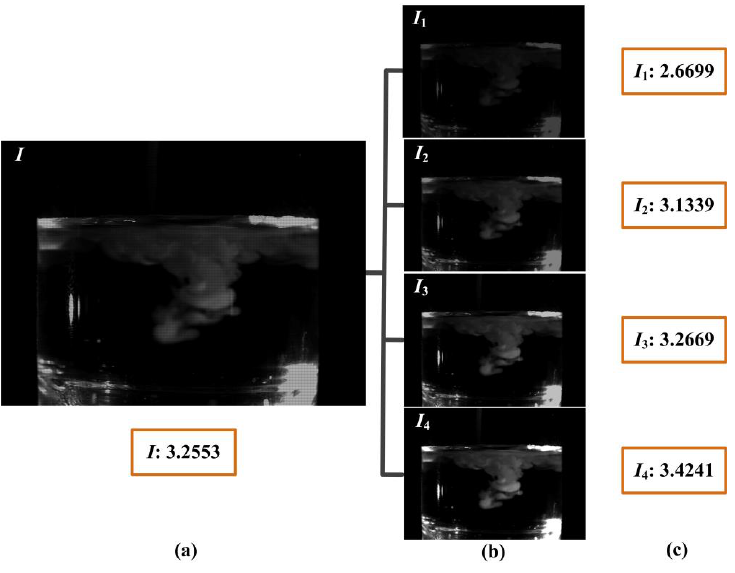
Figure 11. The third example result of coded exposure for subtle change of the liquid mixing motion. ( a ) Coded exposure image I ; ( b ) Subframes: I 1 , I 2 , I 3 , I 4 ; ( c ) Entropy of different frames.